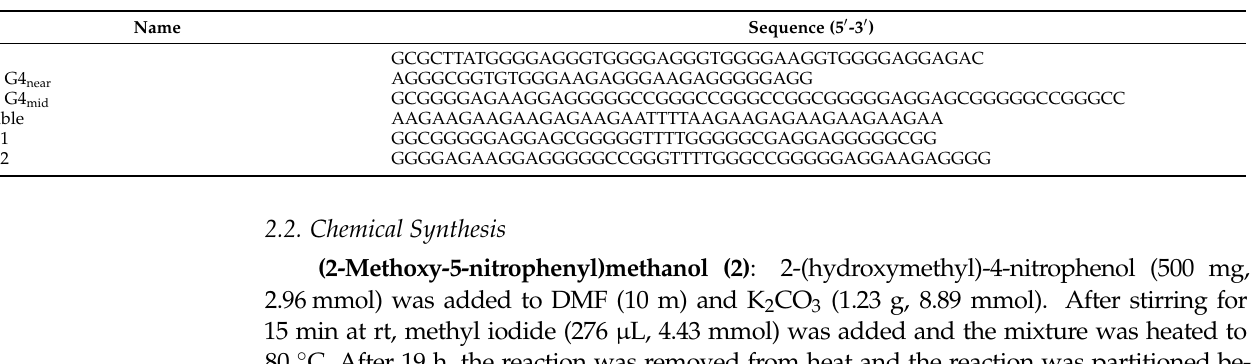
Table 1. Sequences of oligonucleotides used the current